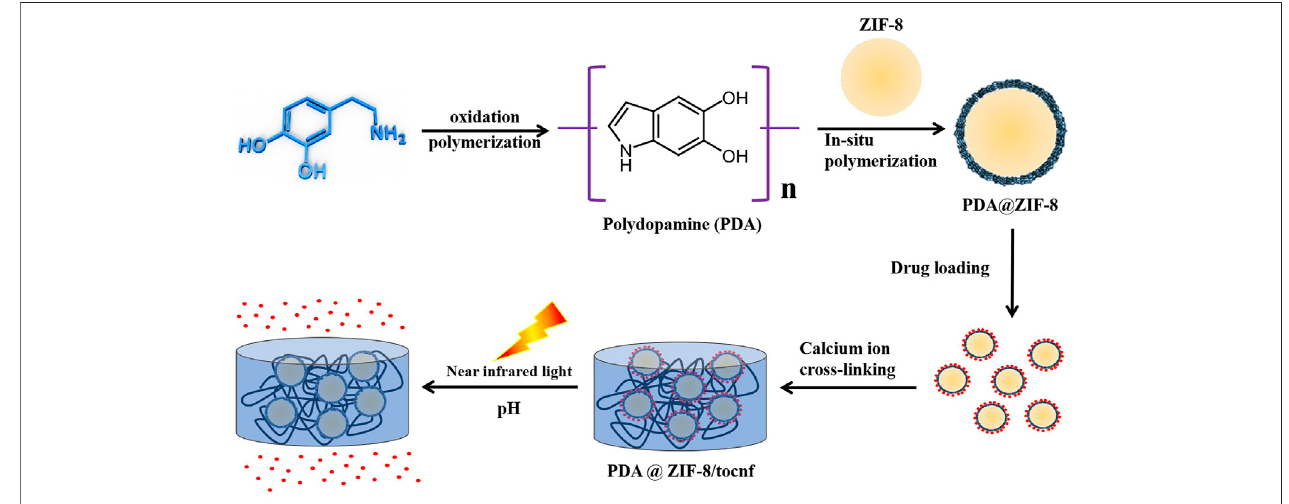
FIGURE 5 | Preparation of composite hydrogel and its application in drug delivery.